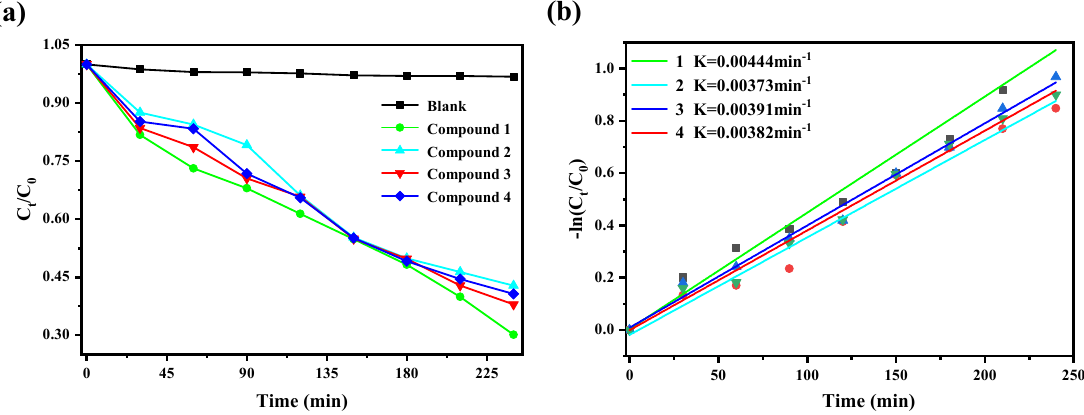
Figure 6. ( a ) The catalytic efficiency of different catalysts on CIP, ( b ) Quasi − first order kinetics of ciprofloxacin degradation by different catalysts.